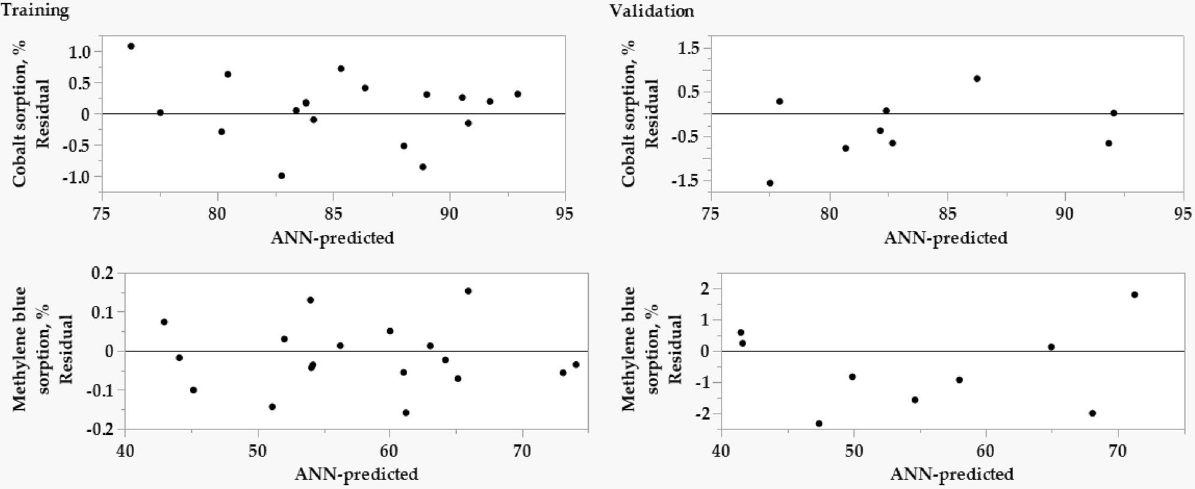
Figure 4. The plots of residuals versus predicted values of both training and validation processes of Cobalt(II) and MB biosorption by the biomass of Sargassum latifolium